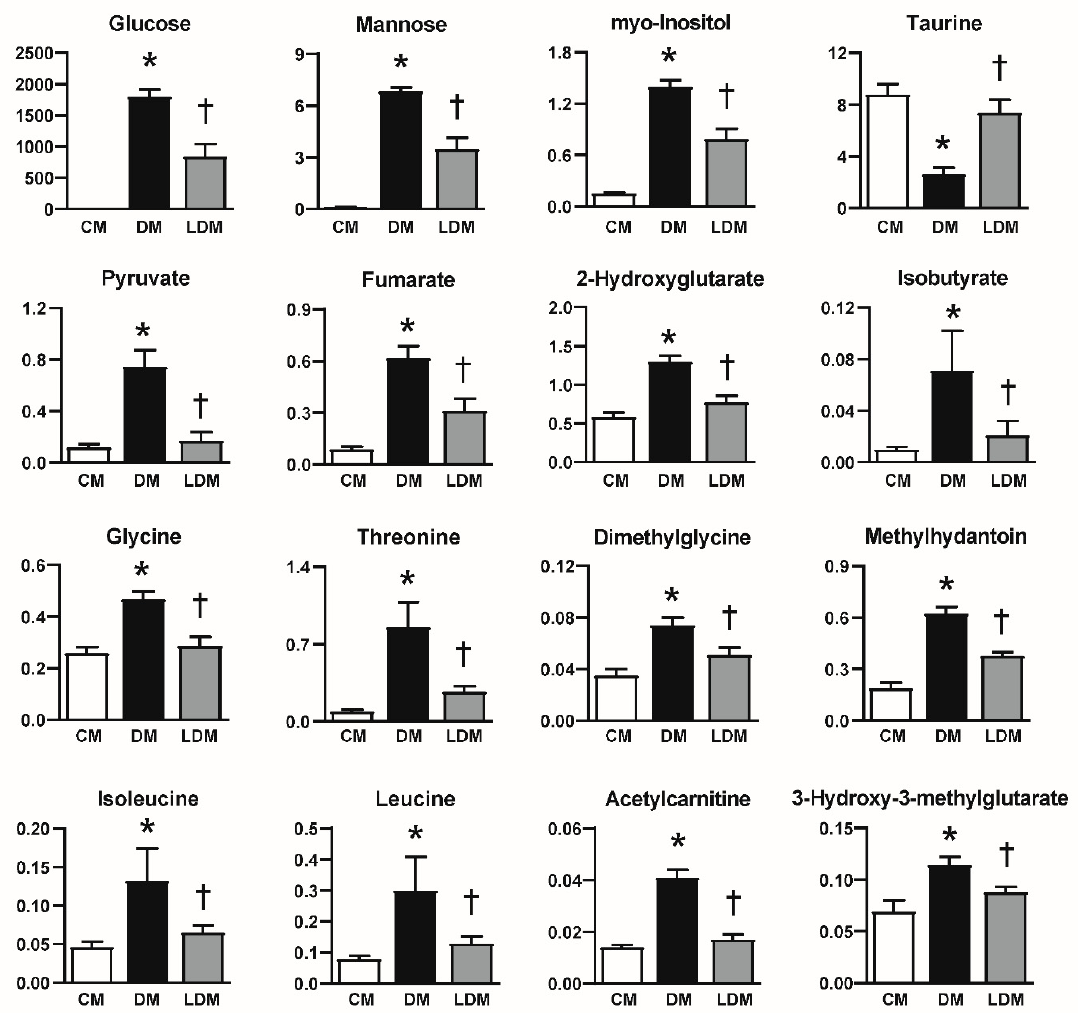
Figure 3. Change of urinary metabolites in LDM compared to DM. Data are presented as the levels of metabolites (metabolite concentration ( µ M) / urinary creatinine concentration ( µ M)). * p < 0.05, di ff erence between CM and DM. † p < 0.05, di ff erence between DM and LDM. CM, control mice; DM, STZ-induced diabetic mice; LDM, losartan-treated diabetic mice.